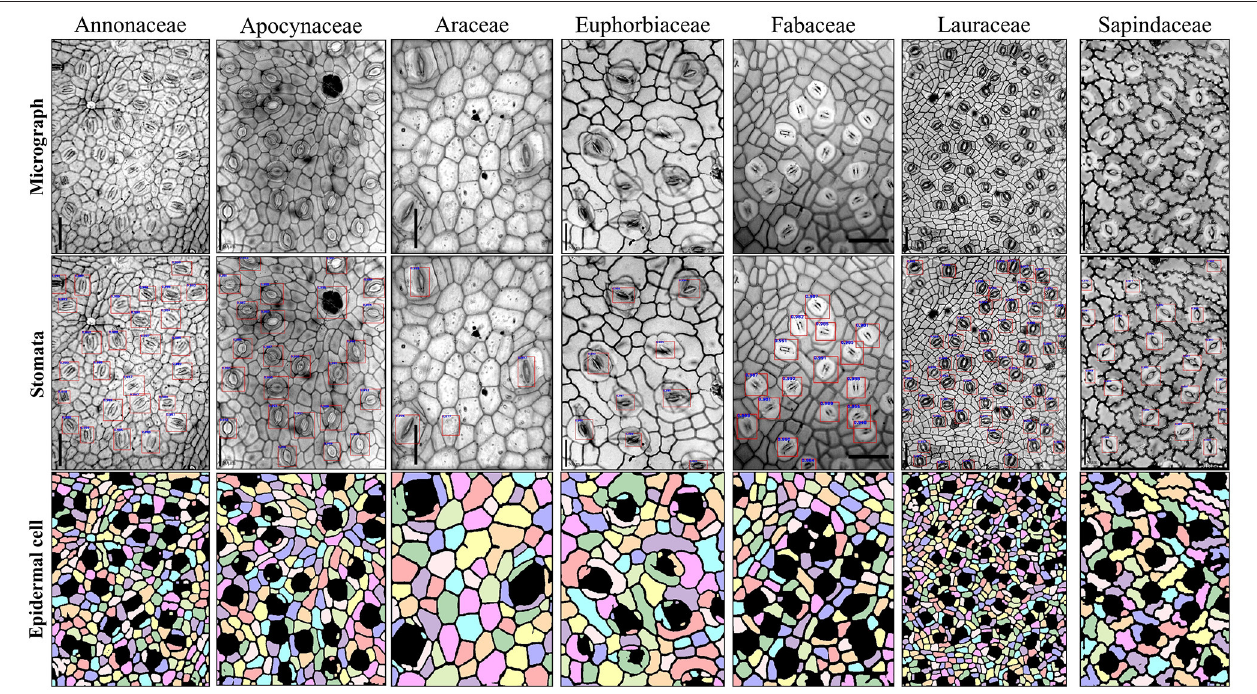
FIGURE 9 | Example images of seven plant families in the testing set of cuticle dataset using stomata detection and epidermal cell segmentation